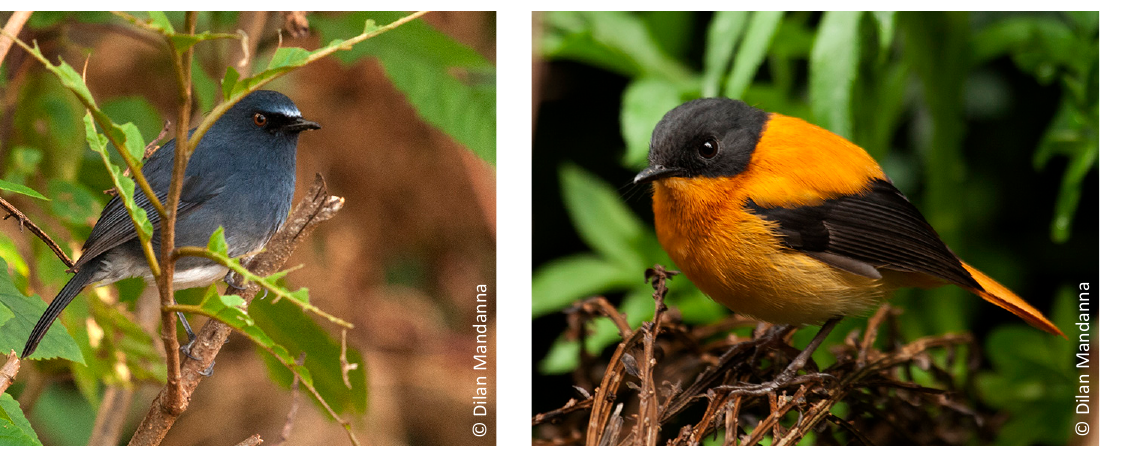
Image 3. White-bellied Shortwing Image 4. Black-and-Orange Flycatcher